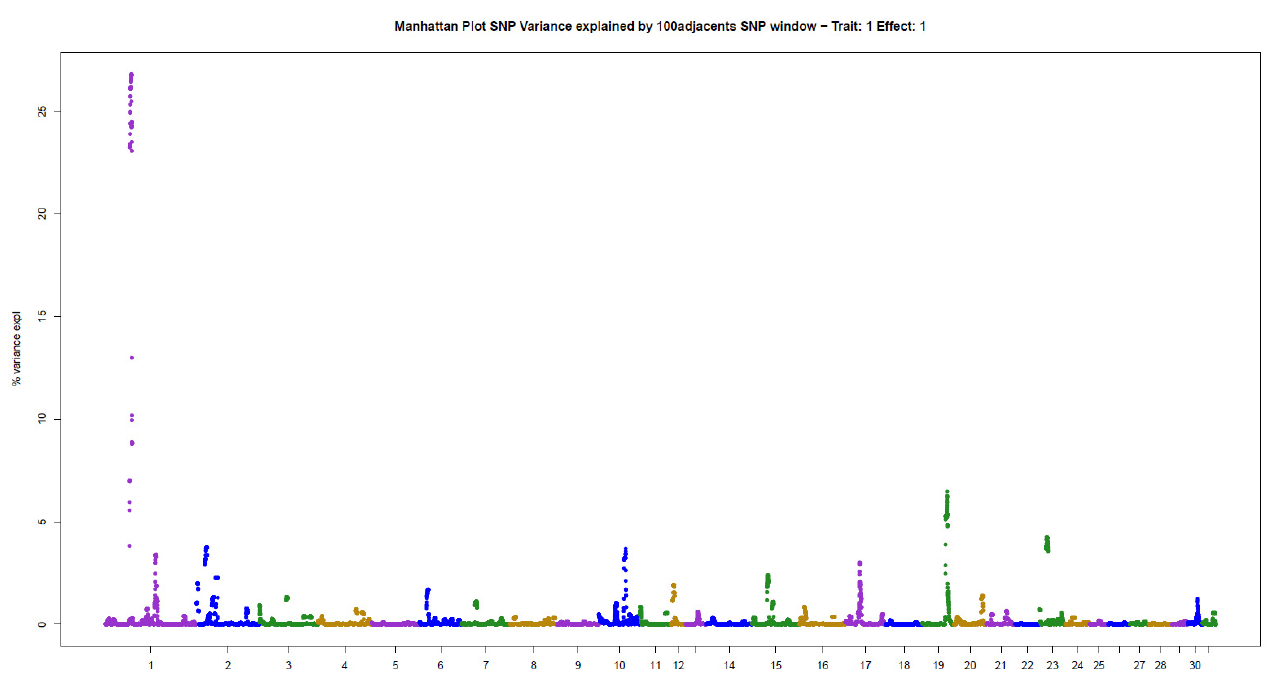
Figure 3. Manhattan plot of hair whorl number on the head of Quarter Horses. The y-axis indicates the proportion of variance explained by windows of 100 adjacent SNPs. The chromosomes are given on the x-axis.